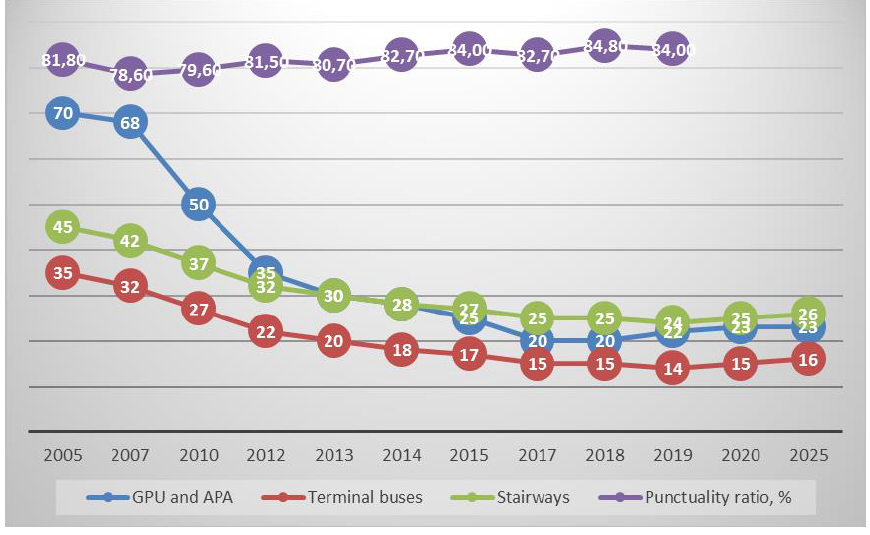
Fig.2. The actual and projected number of certain types of aviation special equipment at the airport, taking into account the introduction of multifunctional PLG